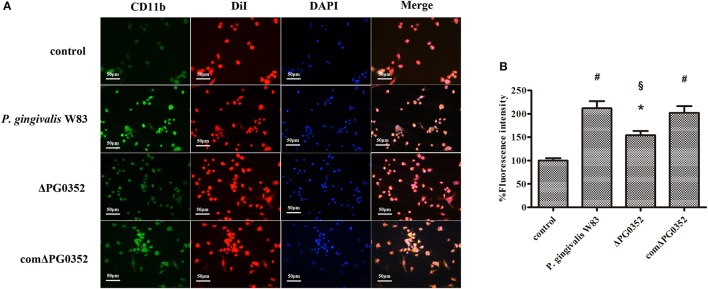
The CR3 expression levels after stimulated by P. gingivalis W83, ΔPG0352 and comΔPG0352. (A) The U937-differentiated macrophages membranes stained with DiI appear red, while the nuclei appeared blue (200×). (B) Analysis of fluorescent levels using IMAGEJ software revealed elevated CD11b levels in P. gingivalis W83, ΔPG0352 and comΔPG0352 groups compared with control group. After 6 h post-infection, the fluorescence intensity of CR3 in P. gingivalis W83 group was about 2 times higher than that in the control group, and about 1.5 times higher than that in ΔPG0352 group. There were no significant differences between P. gingivalis W83 and comΔPG0352 groups. *P < 0.05 vs. control group, #P < 0.01 vs. control group, §P < 0.01 vs. P. gingivalis W83 group, using ANOVA.